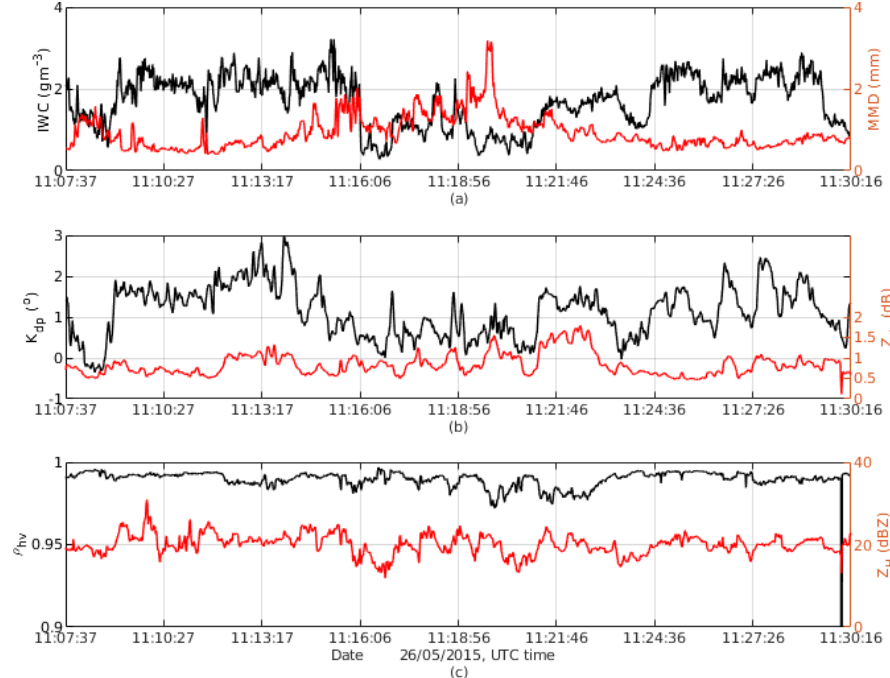
Figure 5. Time series of (a) IWC PSD , MMD, (b) K dp , Z dr , (c) ρ hv , and Z H for 26 May Convair CV-580 flight.